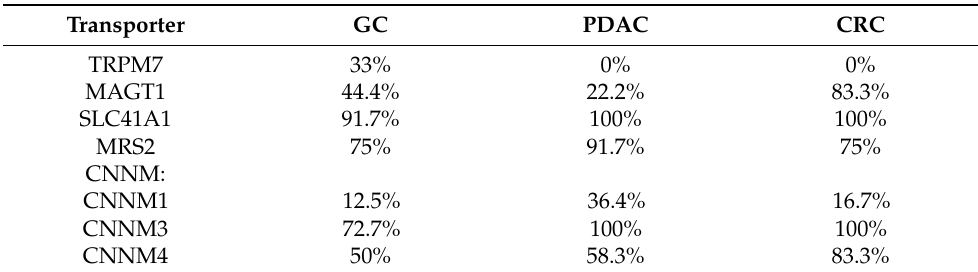
Table 2. Expression of Magnesium transporters using immunohistochemistry (IHC) in some digestive cancers based on The Human Protein Atlas